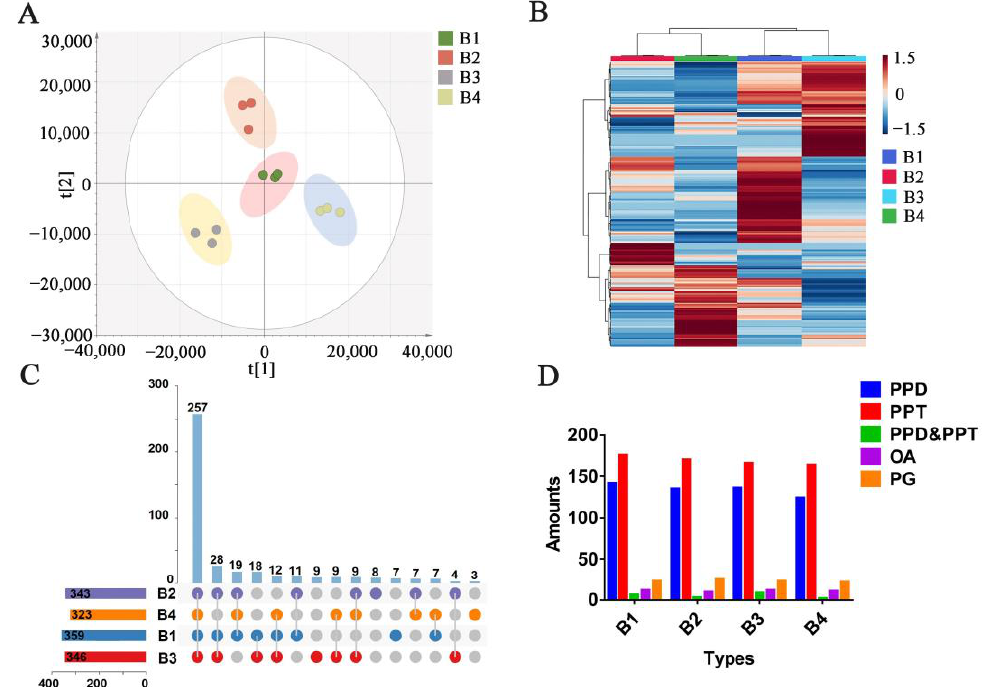
Figure 3. Multivariate statistical analysis of the P. ginseng samples. ( A ) OPLS-DA analysis of 4 groups of P. ginseng , ( B ) heat map analysis of P. ginseng , ( C ) The Venn diagram of 4 groups of P. ginseng , ( D ) Number of different types of ginsenosides in P. ginseng samples.